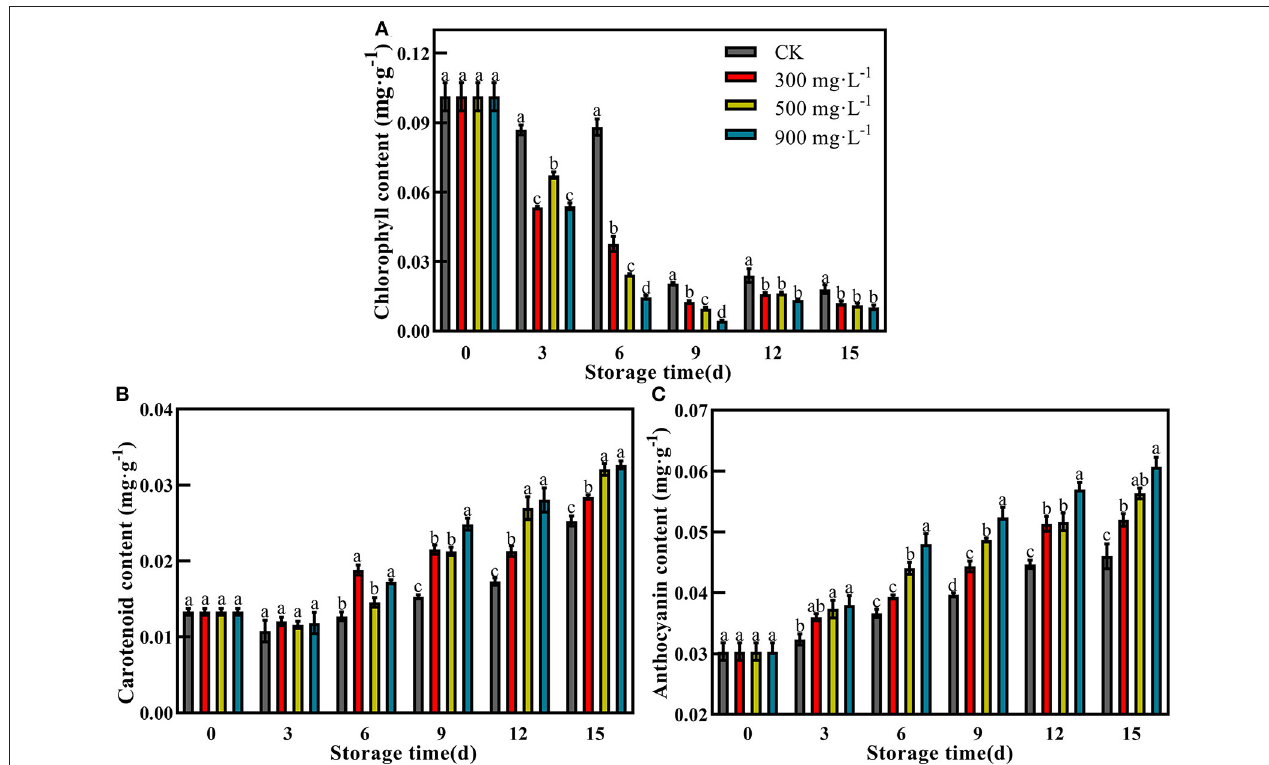
FIGURE 4 | Effects of ETH treatment on contents of chlorophyll (A) , carotenoid (B) , and anthocyanin (C) . Values followed by different letters are significantly different based on Duncan’s multiple range tests at P < 0.05. The error bars indicate the standard deviations of three biological